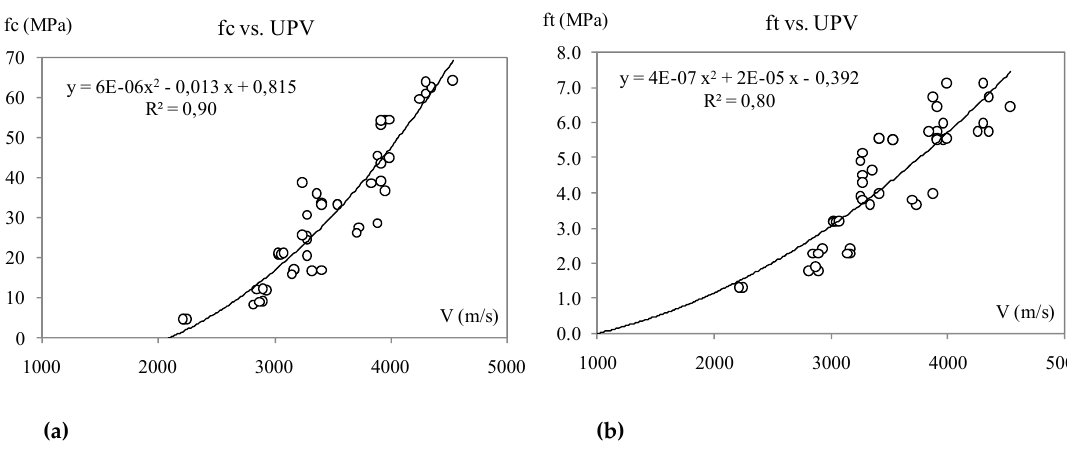
Figure 6. ( a ): The correlation of compressive strength with the ultrasonic pulse velocity f c (V ( b ): The correlation of flexural tensile strength with the ultrasonic pulse velocity f t (V). The f c (V) and f t (V) relationships for fly-ash geopolymer mortars 10N, 30N, and 50N; all results obtained collectively after 1, 3, 7, 14, and 28 days.